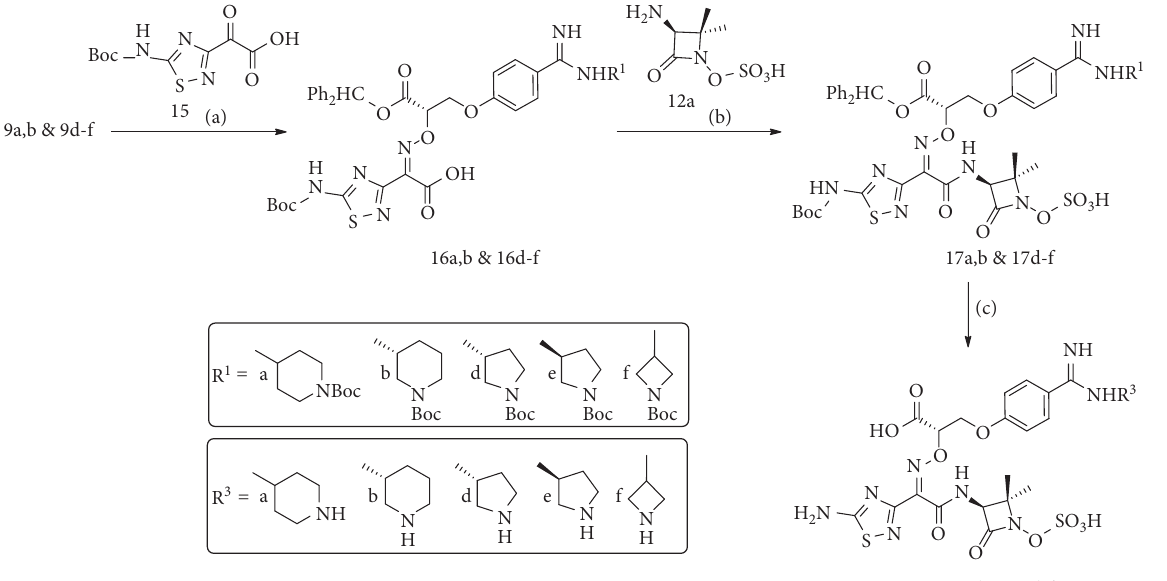
Scheme 4: Synthesis of compounds 18a,b and 18d – f . Reagents and conditions: (a) 15 , EtOH-CHCl NaHCO 3 , DMF, 0 ° C – rt, 41–84%; (c) TFA, CH 2 Cl 2 , 0 ° C – rt,